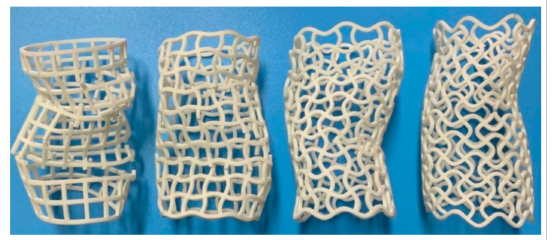
Figure 10. The tubes after unloading.